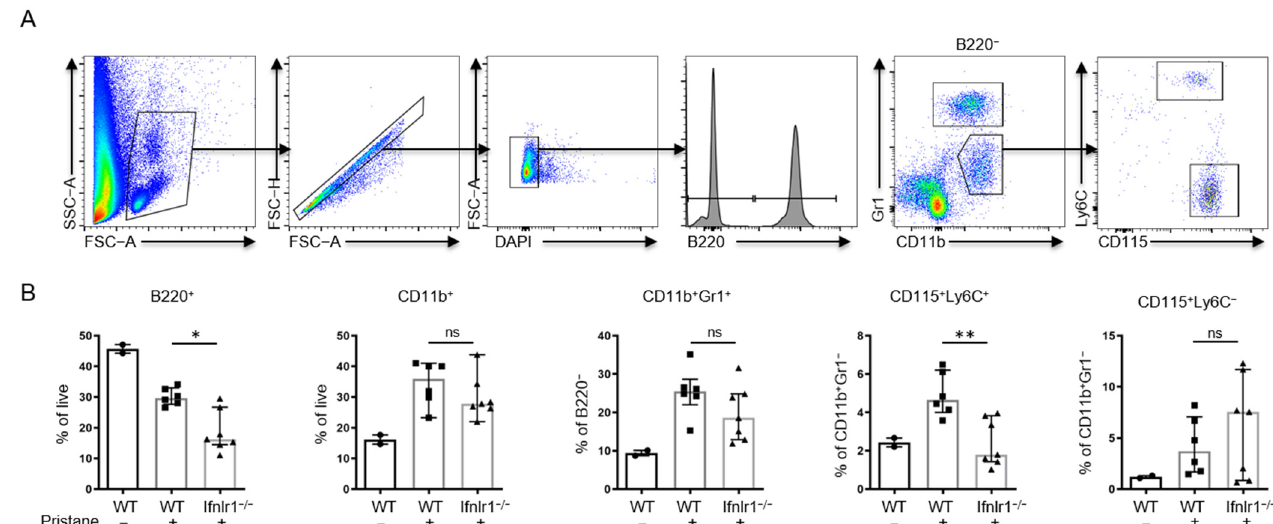
Figure 6. Ifnlr1 − / − mice show an increased proportion of peripheral CD115 + Ly6C + monocytes at 2 weeks after pristane treatment. ( A ) Gating strategy for the flow cytometric analysis of peripheral blood leukocytes. ( B ) Proportion of indicated populations among total living single cells or among indicated subpopulations. Each symbol represents an individual sample and all samples were included. Bars represent median with interquartile range. Bars represent group mean ± SD. Statistical analyses to compare WT + pristane vs. Ifnlr1 − / − + pristane were performed using Mann–Whitney U test. * p < 0.05, ** = p < 0.005, ns = not significant. Values of WT without pristane are shown as reference.